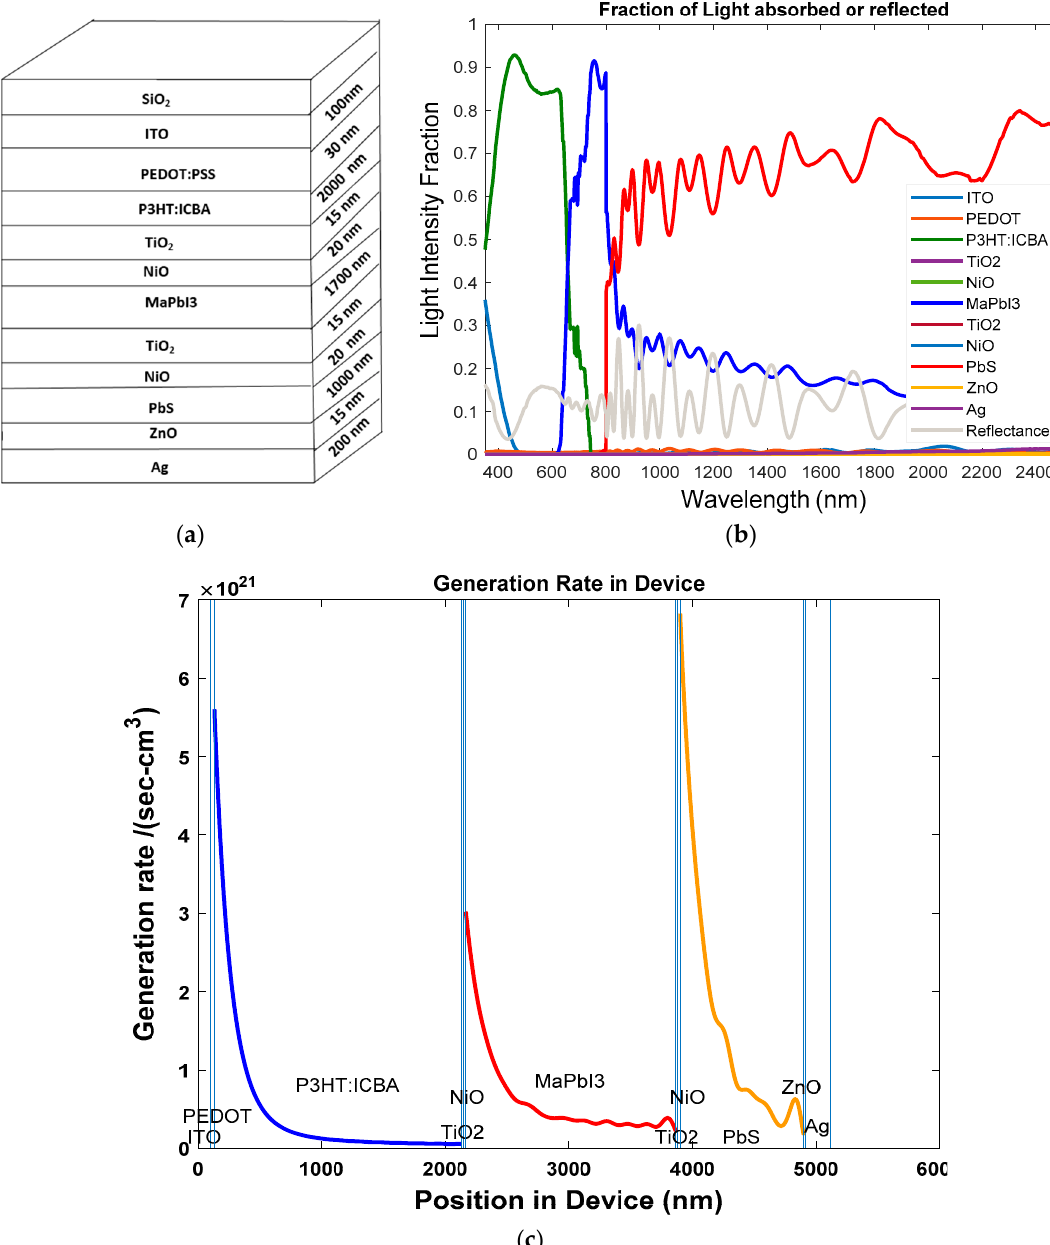
Figure 9. ( a ) Stack diagram; ( b ) variation of light intensity versus wavelength; and ( c ) exciton generation rate vs. position of device for three-junction hybrid solar